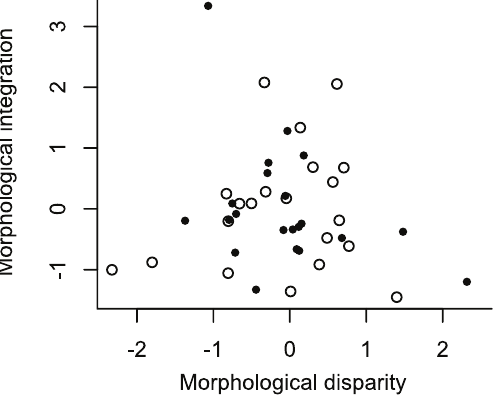
Figure 2. Correlation between temporal changes in disparity and integration. Spearmann’s rank correlation between level of morphological disparity and degree of morphological integration. (A) Generalized differences of morphological integration versus disparity for the PCoA-based approach (black circles; r = 2 0.118, P =0.609) and the discrete character approach (open circles; r = 2 0.449, P =0.042) when all characters are considered. (B) Generalized differences of morphological integration versus disparity for the PCoA-based ap- proach (black circles; r = 2 0.340, P =0.131) and the discrete character approach (open circles; r =0.118, P =0.609) when only taxonomically non-significant characters are considered (see text). In general, the amount of morphological disparity displayed by crinoids is not significantly correlated with the overall degree of integration among morphological